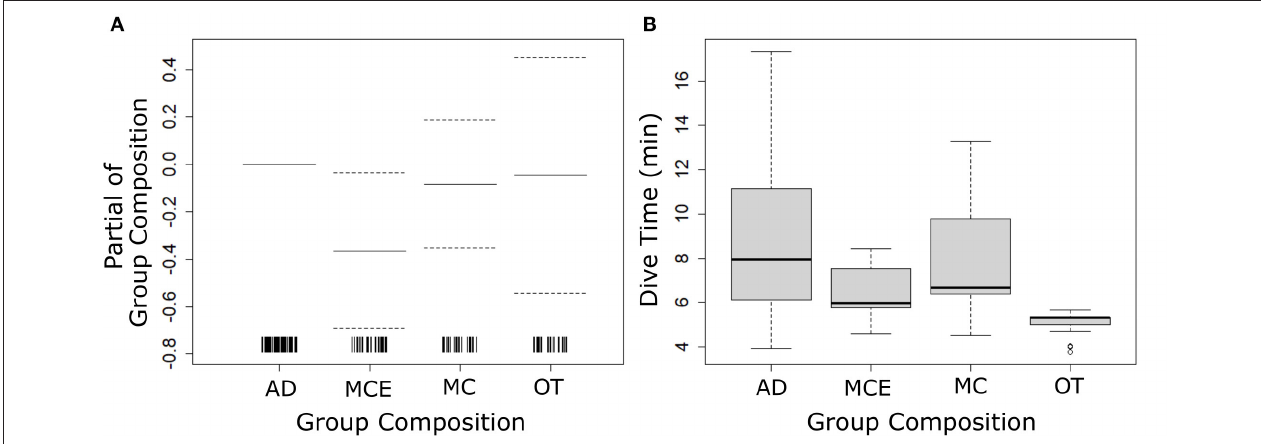
FIGURE 4 | Results from the best fit generalized additive model (GAM) for humpback whale dive time showing (A) model parameter estimates of group composition (AD-adult, MCE-mother-calf-escort, MC-mother-calf; OT-other) and (B) model predicted dive times based on group composition. Dashed lines in image (A) represent the 95% confidence intervals of the parameter estimate, and vertical ticks indicate the locations of observations (i.e., a rugplot).